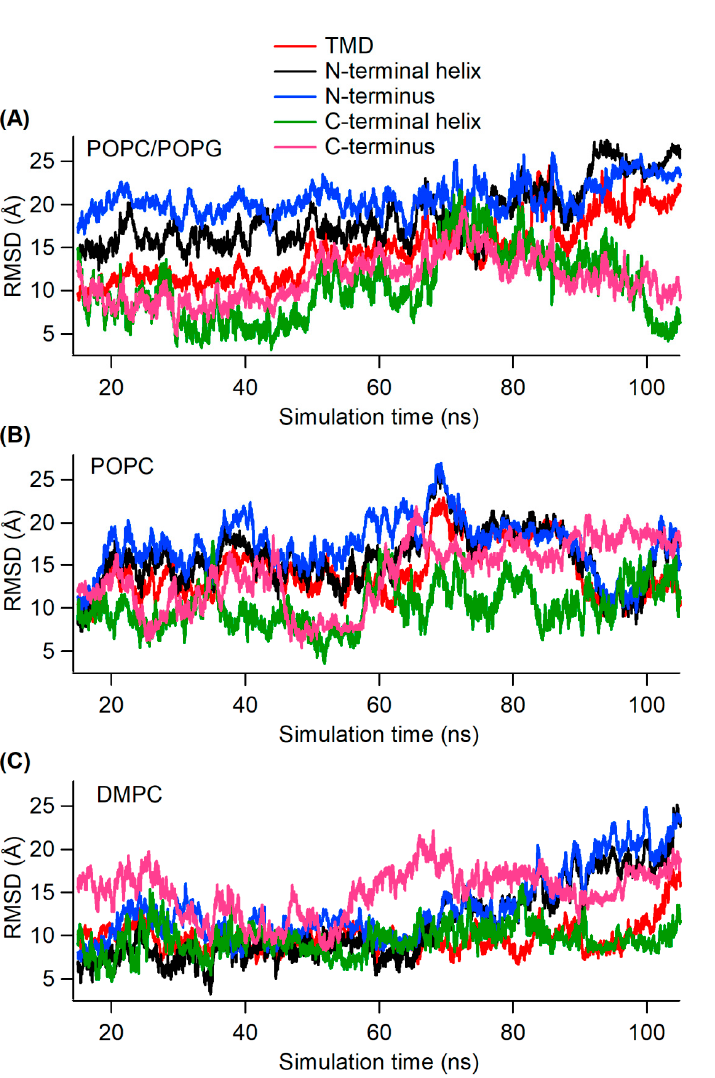
Figure 3. Root mean square deviation (RMSD) as a function of simulation time for different segments of KCNE3 in POPC/POPG ( A ), POPC alone ( B ), and DMPC ( C ).